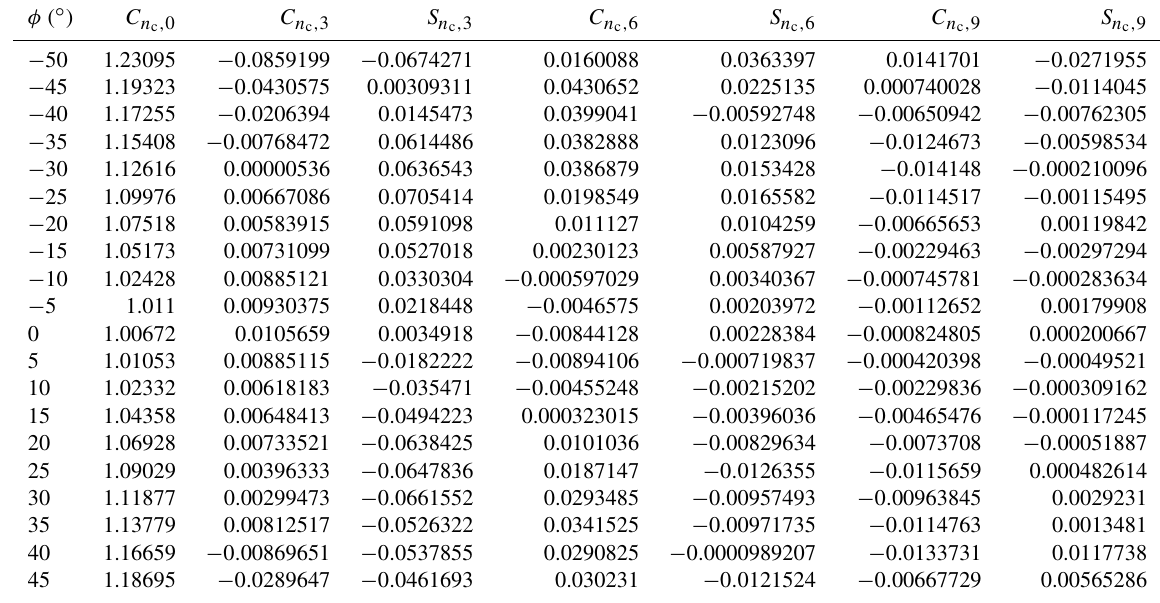
Table A3. LUT for n c (α,φ)